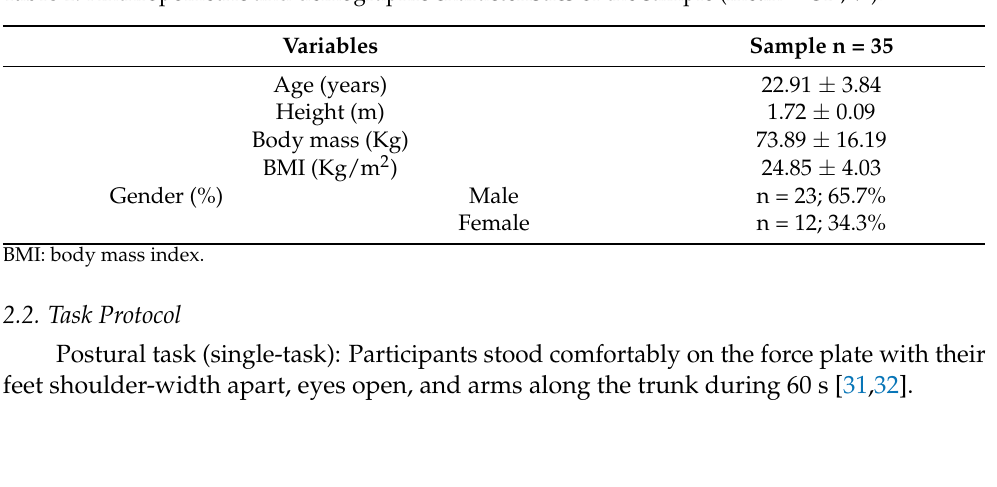
Table 1. Anthropometric and demographic characteristics of the sample (mean ± SD;